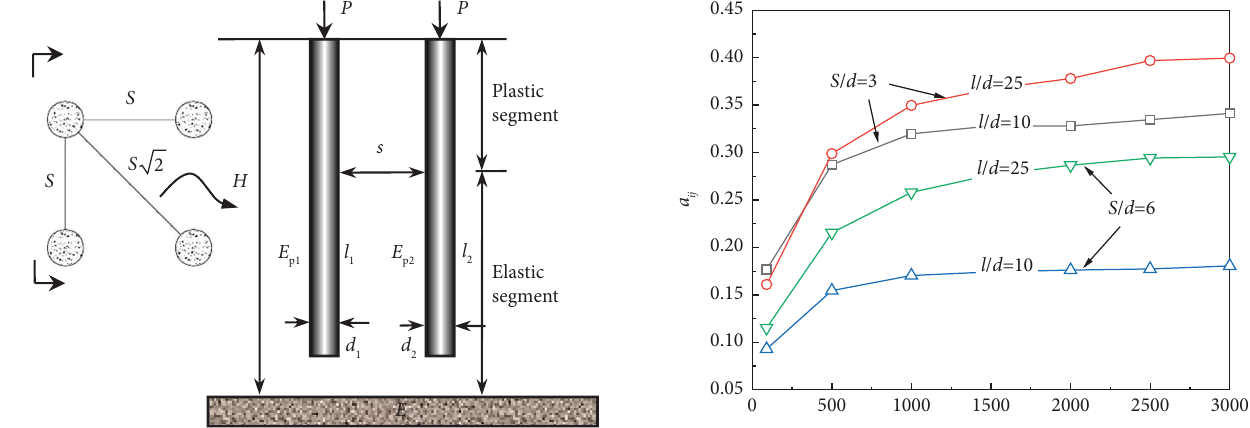
Figure 1: A 2 × 2 pile confguration depicting interaction between the